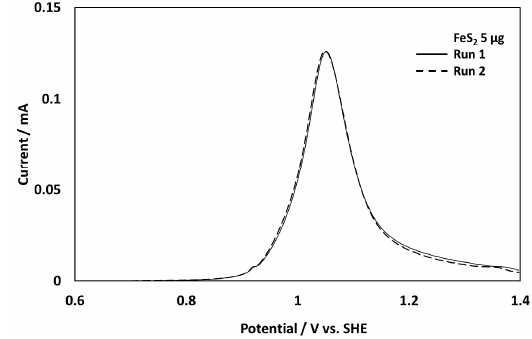
Figure 1. Potential polarization with 5 µ g of pyrite that is attached to the platinum plate surface. Experiments were repeated (runs 1 and 2) to determine the reproducibility.